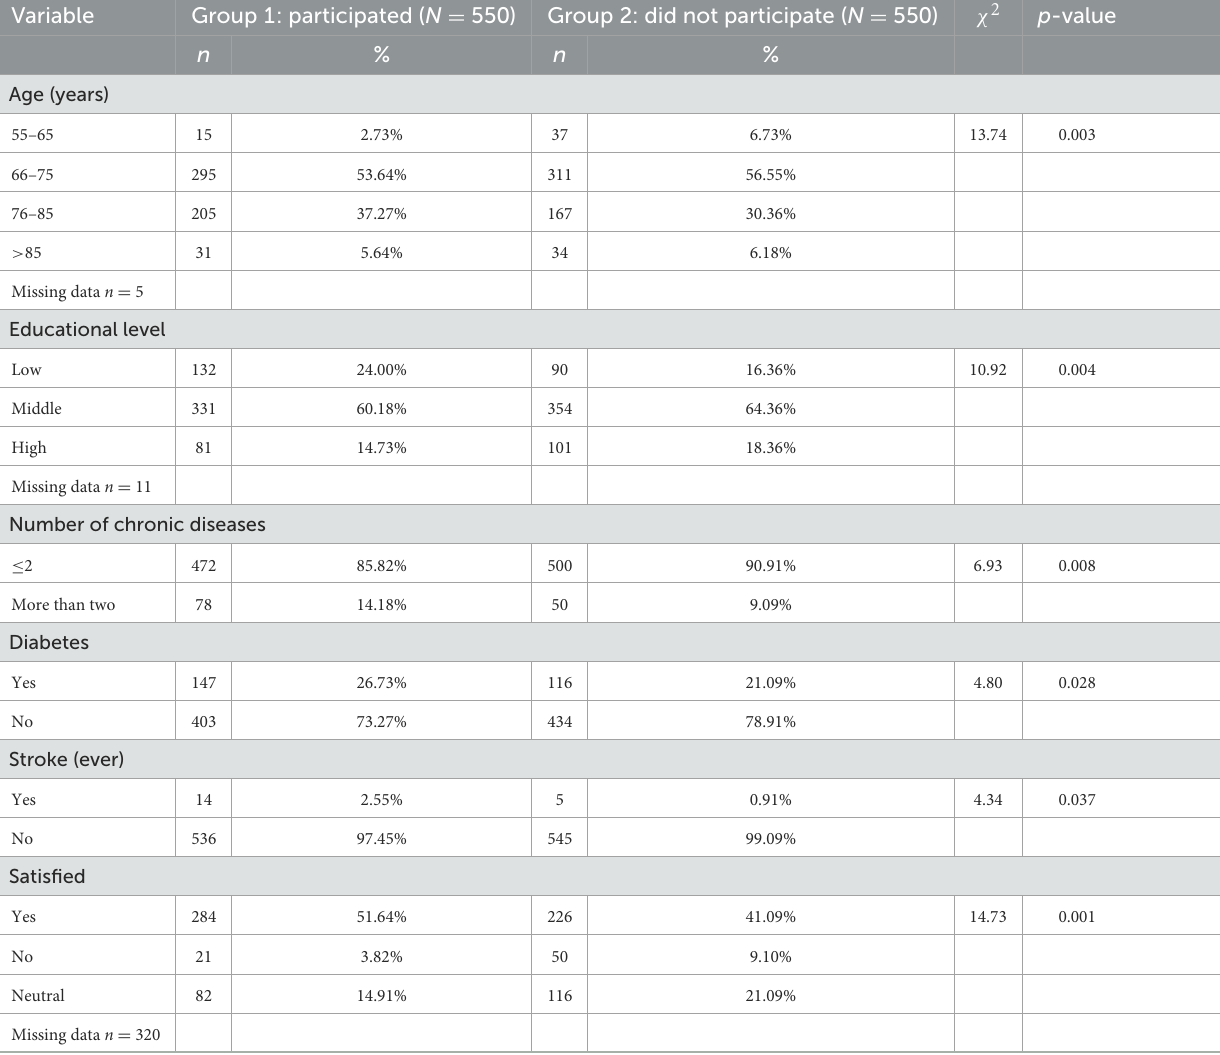
TABLE 3 Bivariate correlates of participation in the elderly health checkup program (EHCP) among the elderly.